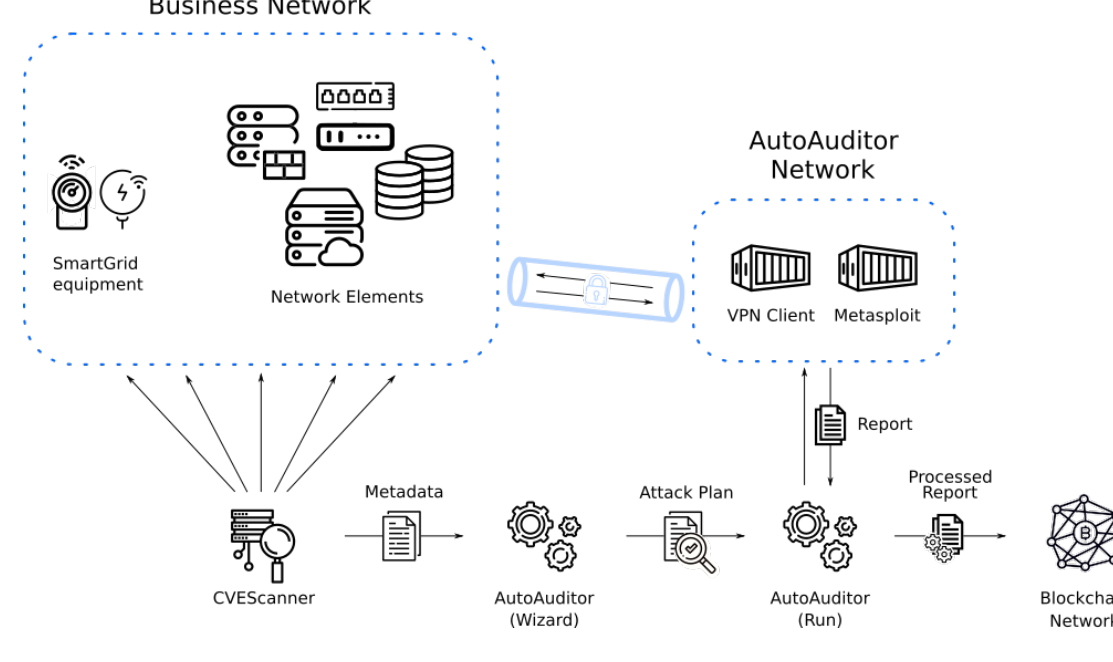
Figure 1. AUTOAUDITOR